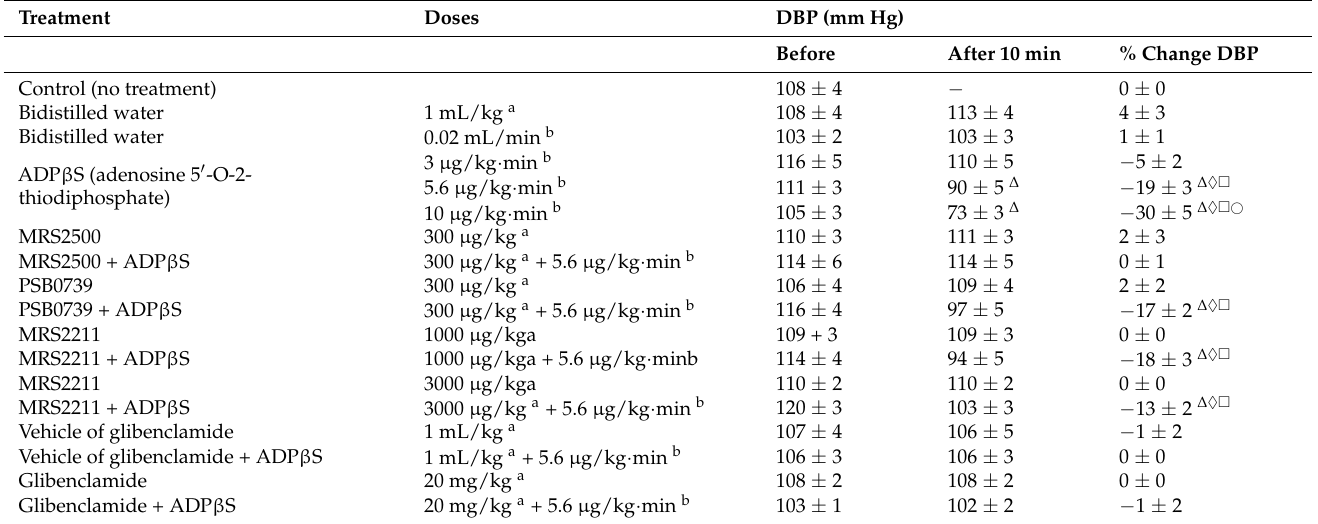
Table 1. Values of diastolic blood pressure (DBP) in pithed rats after i.v. treatment with gallamine followed by the continuous infusions of hexamethonium and methoxamine before (baseline) and 10 min after i.v. administration of several